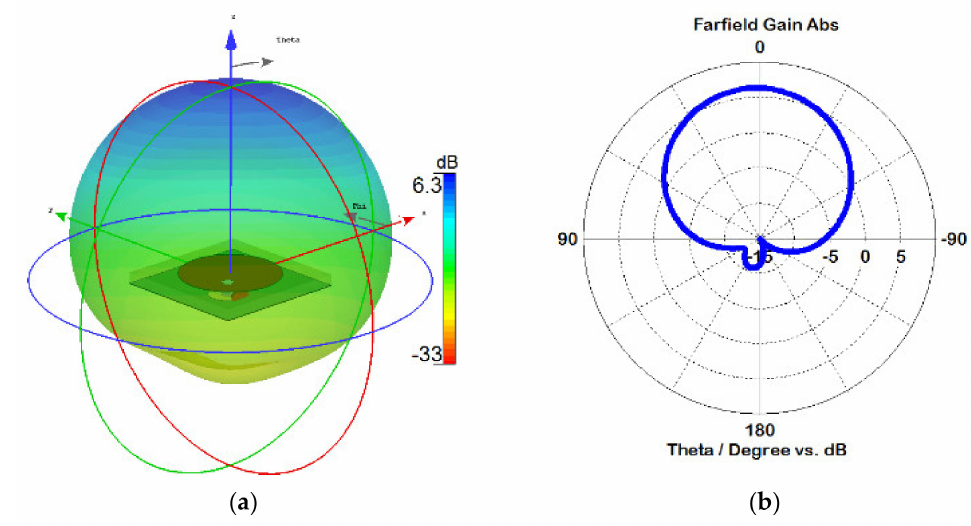
Figure 3. Radiation patterns of the proposed antenna at 60 GHz: ( a ) 3D; ( b ) 2D.